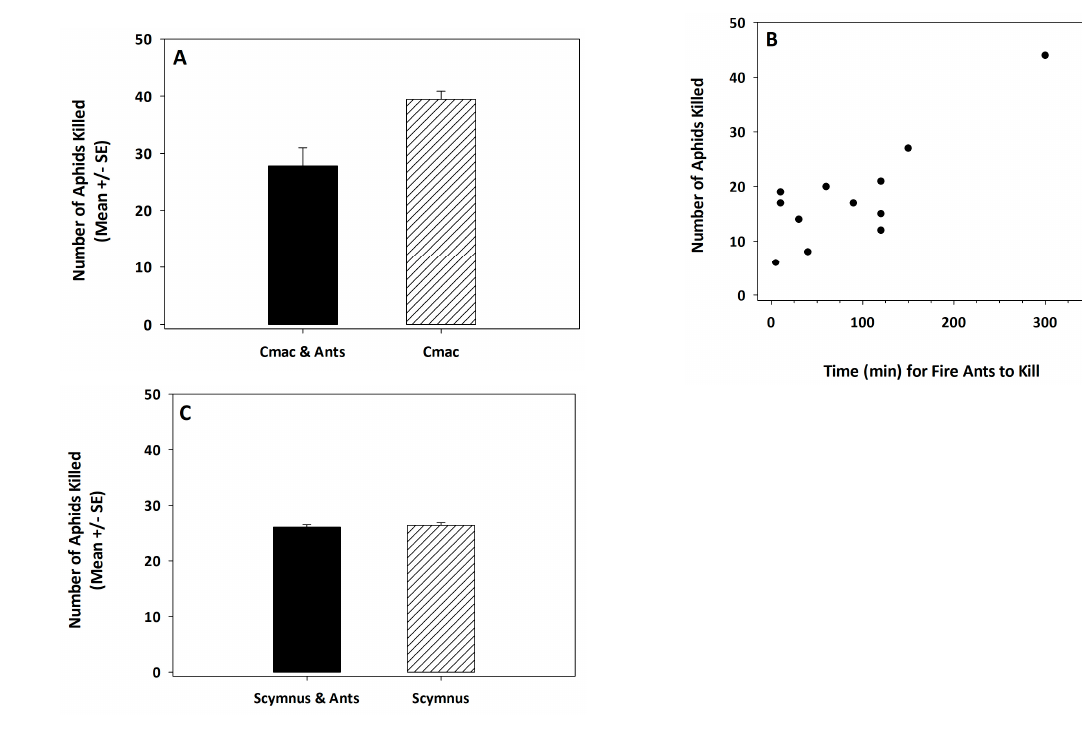
Figure 2. The mean ± SE number of aphids killed by 3rd instar C. maculata in the presence or absence of S. invicta ( A ), and a scatterplot of the number of aphids killed by C. maculata versus the time (min) required for S. invicta to kill C. maculata ( B ). The mean ± SE number of aphids killed by 3rd instar Sc. creperus in the presence or absence of S. invicta ( C ). The sample size was 40 observations for the test with C. maculata and the test with Sc. creperus . The scatterplot represented 13 observations. The mean ± SE number of R. padi killed by 3rd instar Sc. creperus was not a ff ected by the presence of S. invicta ( t = 0.45, df = 38, p = 0.651; Figure 2C). Moreover, the mean (± SE) proportion of R. padi killed during the 7-h test period was 0.52 (± 0.009) and 0.53 (± 0.01) in the Sc. creperus and S. invicta treatment or Sc. creperus alone, respectively. There were 50 R. padi nymphs and adults in each arena at the onset of the experiment with Sc. creperus . Generally, S. invicta workers were not aggressive to Sc. creperus ; no Sc. creperus were killed in any of the arenas.